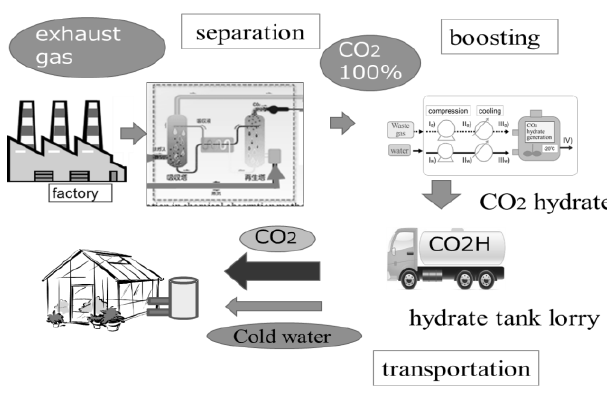
Figure 2. Transportation by truck type.